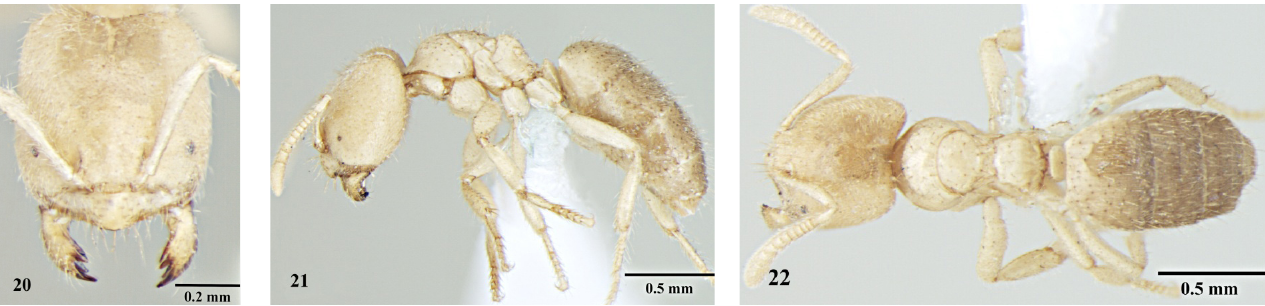
Fig. 20-22 . Pseudolasius polymorphicus sp. n . , media worker 20) head, full face view; 21) body lateral view; 22) body, dorsal view.